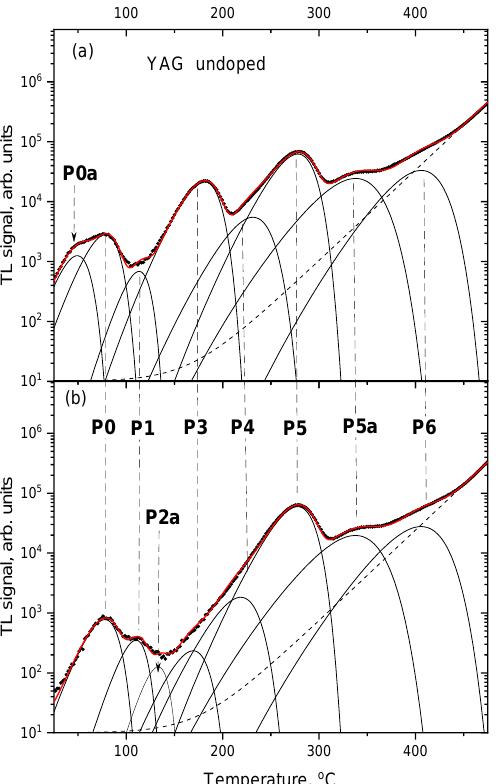
Figure 11. TL glow-curves of YAG undoped crystal deconvoluted into single peaks. ( a ) no IR illumination, ( b ) after 2000 s of IR illumination. Dose 2 Gy.